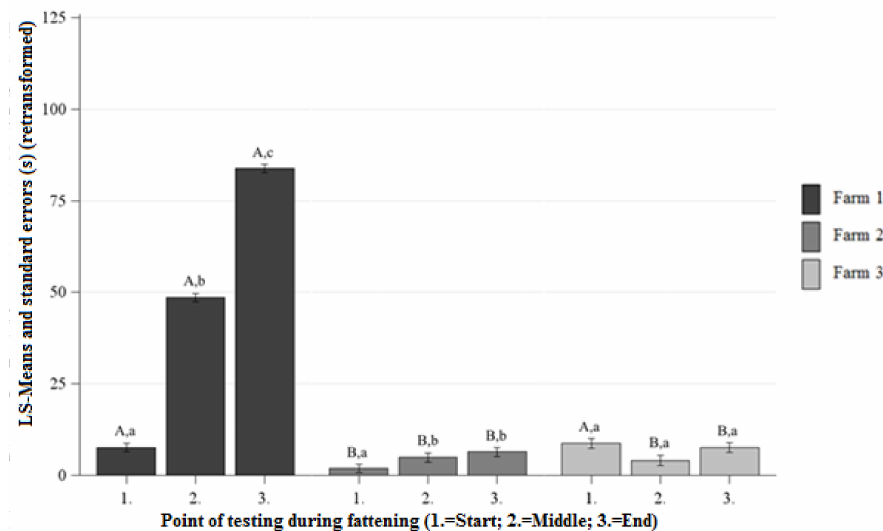
Figure 2. Least squares means-means and standard errors (in seconds) (retransformed) of the duration of contact in the HAT at each point of testing; a, b, c letters indicate significant di ff erences within the farm between the di ff erent points of testing ( p < 0.05); A, B, C letters indicate significant di ff erences between the farms within the di ff erent points of testing ( p <